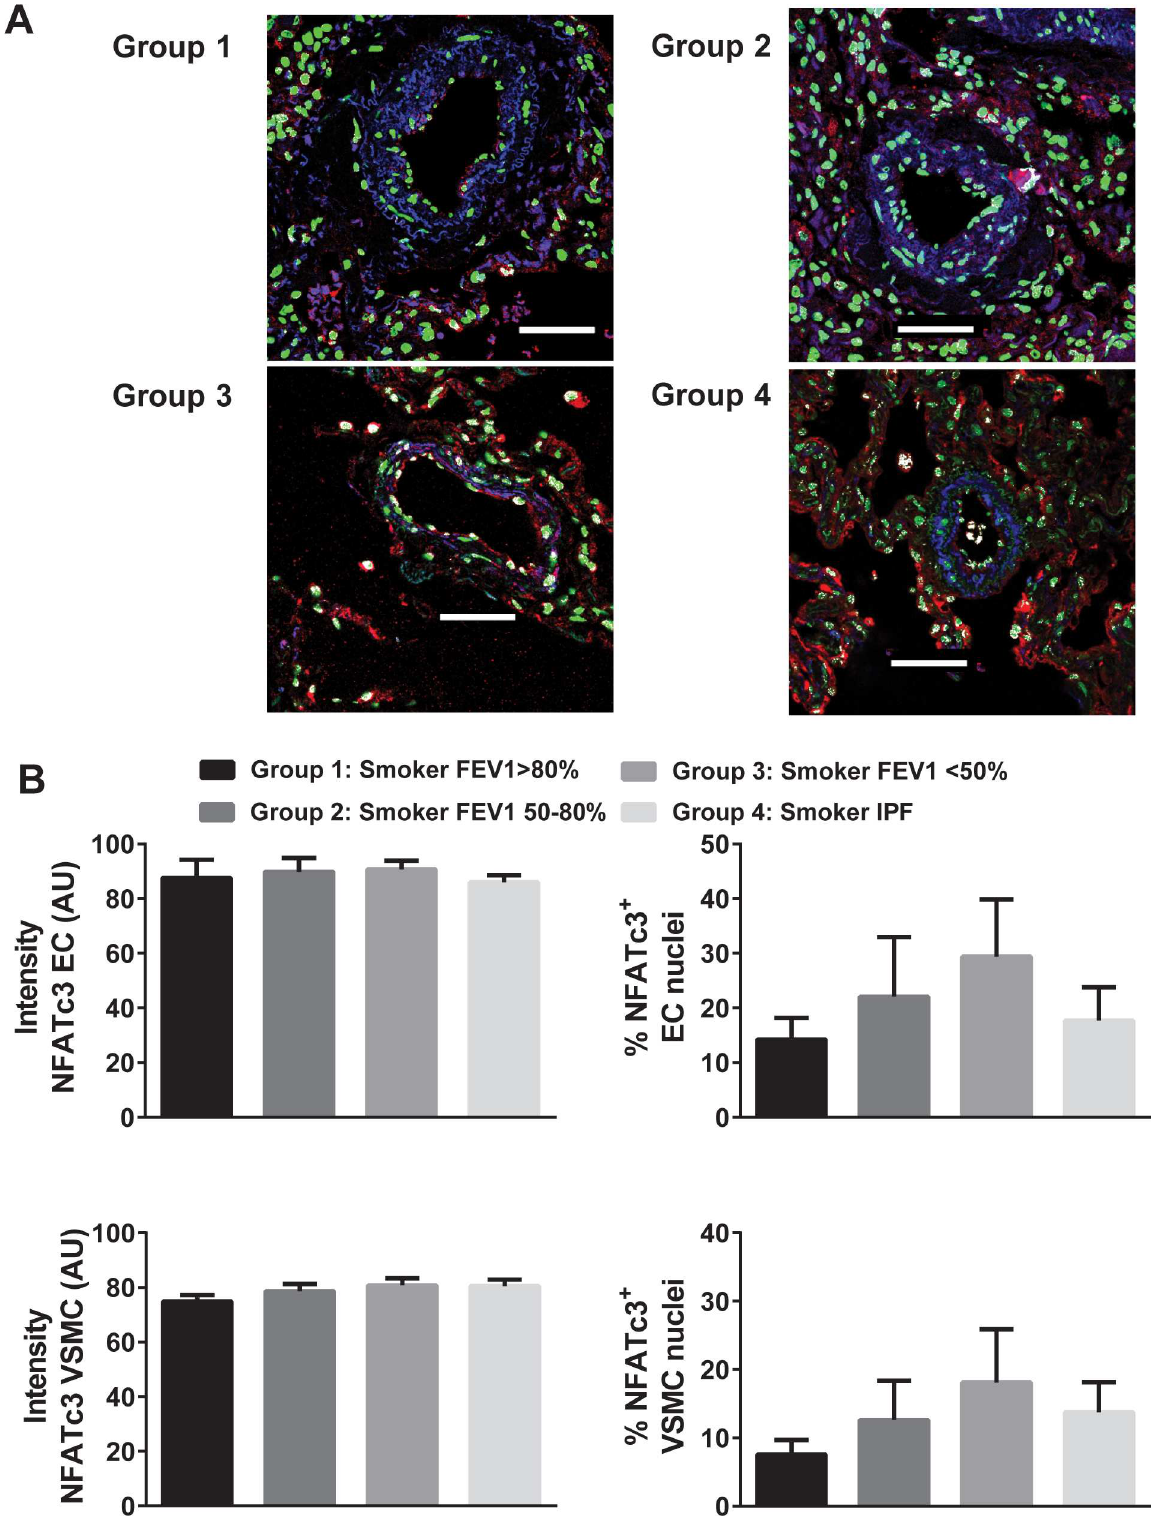
Fig 4. NFATc3 activity and expression in pulmonary arteryendothelial and smooth muscle cells from lungs from COPD and IPF patients. A) Representative images of NFATc3 (red) and smooth muscle alpha-actin(blue) immunostainingof lung sections